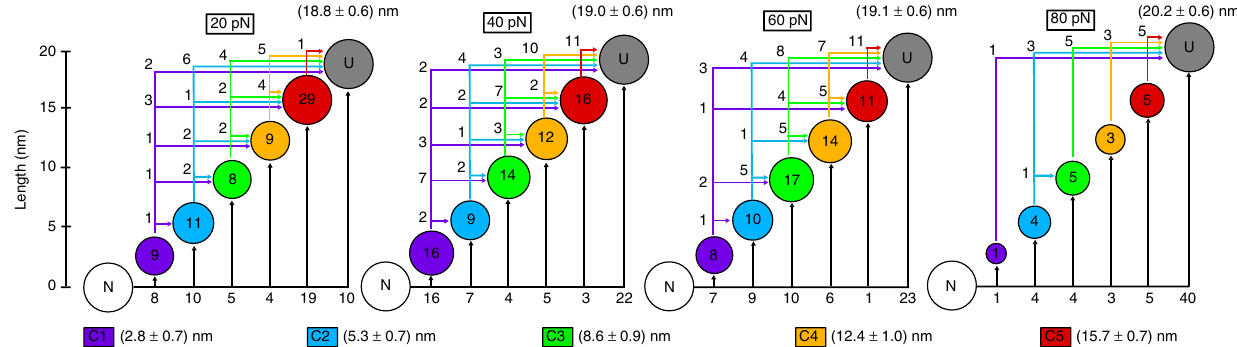
C1 (2.8 ± 0.7) nm Figure 4 | Csp unfolding intermediates and kinetic connections. Cluster analysis permits to group and classify the complex mechanical unfolding patterns of Csp in terms of a series of intermediates and the kinetic transitions between them. Average length and s.d. for each identified intermediate are listed at the bottom of the figure. The corresponding length and s.d. for the unfolded state U was estimated by calculating the average of the distribution of clusters C6–C8 for each individual force and is shown in each panel above the circle corresponding to U . The diameter of each circle (shown in the appropriate colour) is related to the number of times that intermediate was found at each force (to facilitate plotting all data on the same scale, the diameter of the circle was defined by a threshold value assigned to a single occurrence plus a value proportional to the logarithm of the total number of occurrences). The actual number of occurrences for each intermediate as a function of force is included inside the circle. Kinetic transitions from the native state to intermediates are shown as black arrows, whereas transitions from one intermediate to another one are shown as arrows in the colour of the intermediate of origin. Numbers next to each arrow indicate the number of such transitions